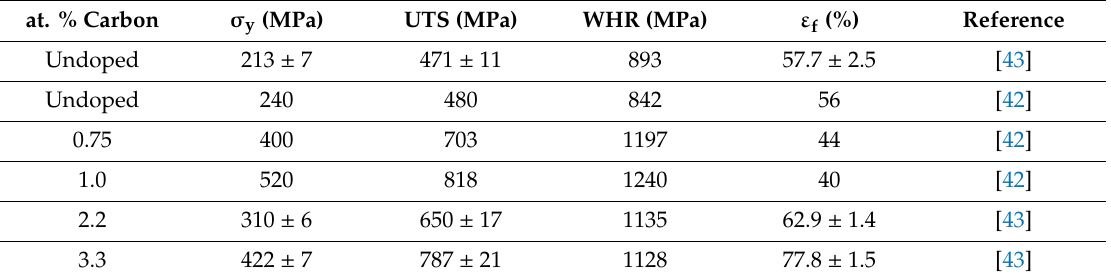
Table 3. The yield strength, σ y , ultimate tensile strength, UTS, work-hardening rate, WHR, and elongation to failure, ε f , for Fe 40 Mn 40 Co 10 Cr 10 HEAs with various C contents. From Wei et al. [42] and Chen et al.